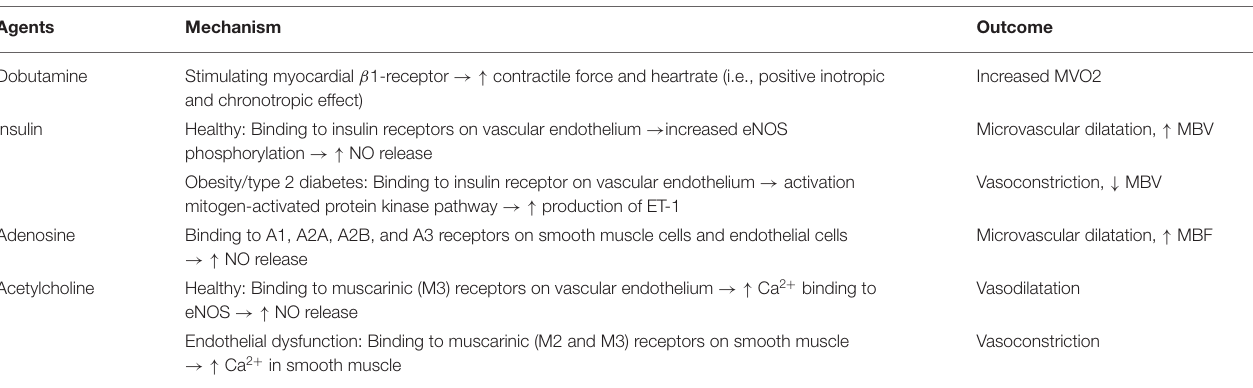
TABLE 2 | Overview of stressors used to test the regulation of MBV.